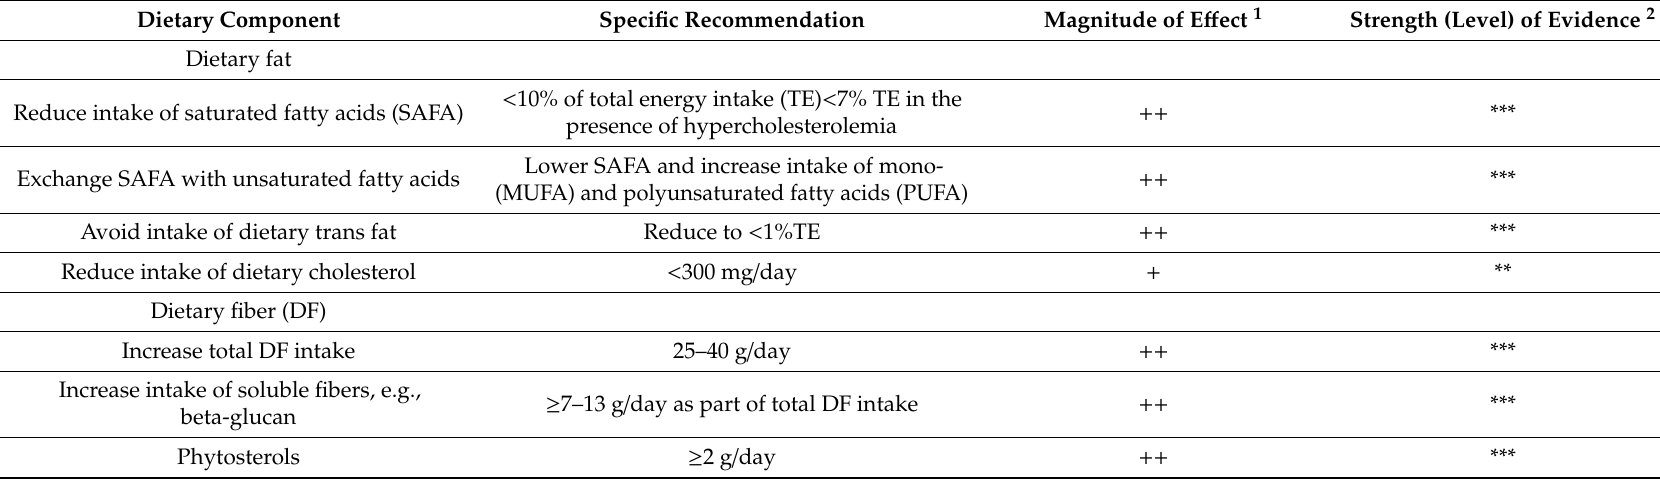
Table 1. Impact of specific dietary changes in the management of dyslipidemia with focus on lowering low-density lipoprotein cholesterol (LDL-C)